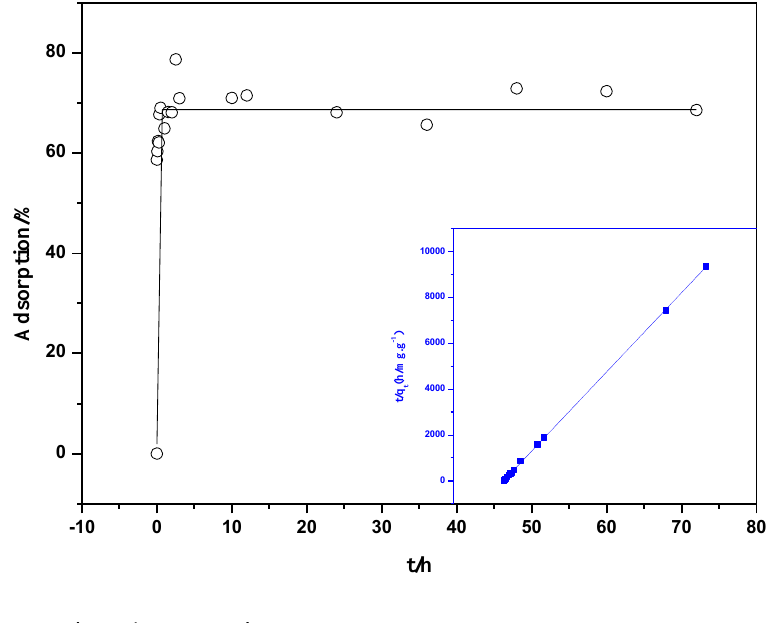
Figure 4. Effect of contact time on Th(IV) adsorption rate onto oMWCNTs and test of pseudo-second-order adsorption kinetics plot for Th(IV), m/V = 0.1 g/L, T = 25 ± 1